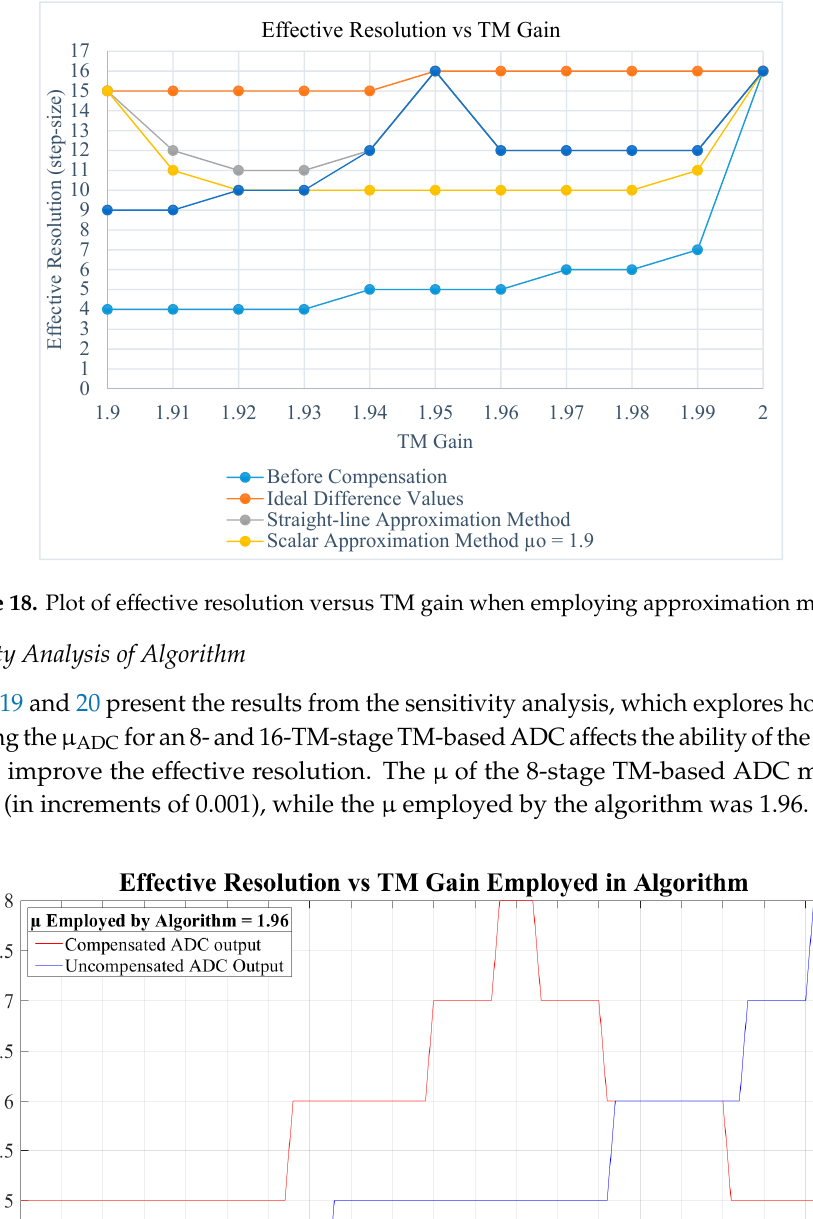
Figure 20. Sensitivity analysis results from a 16-stage TM-based ADC. 4. Discussion and Conclusions The novel TM-based ADC algorithm, for the compensation of non-ideal TM-stage gain, is detailed in this paper. When using the ideal DM parameter values calculated using Equation (2), the compensation algorithm improved the effective resolution of a 16-, 20-, and 24-stage ADC by an average of 10.5, 14.2, and 18 bits, respectively, over a 1.9 ≤ µ ≤ 1.99 range, giving an average effective resolution of 15.5, 19.2, and 23 bits, respectively. It is noted that the further µ is from the ideal value of 2, the less effective the compensation algorithm, hence once µ falls below a certain value (1.95, 1.96, and 1.97 for 16-, 20-, and 24-stage ADC, respectively) it is impossible for the algorithm to increase the effective resolution to the same level as the ideal gain due to the number of missing codes. Achieving a µ > 1.9 will be possible in a circuit implementation, thus the algorithm will not be attempting to compensate for further losses in the ADC output accuracy. The results from the FPGA implementation of the compensation algorithm demonstrates a 3-bit improvement in the ADC effective resolution from 4 to 7 bits. In addition, this was possible even